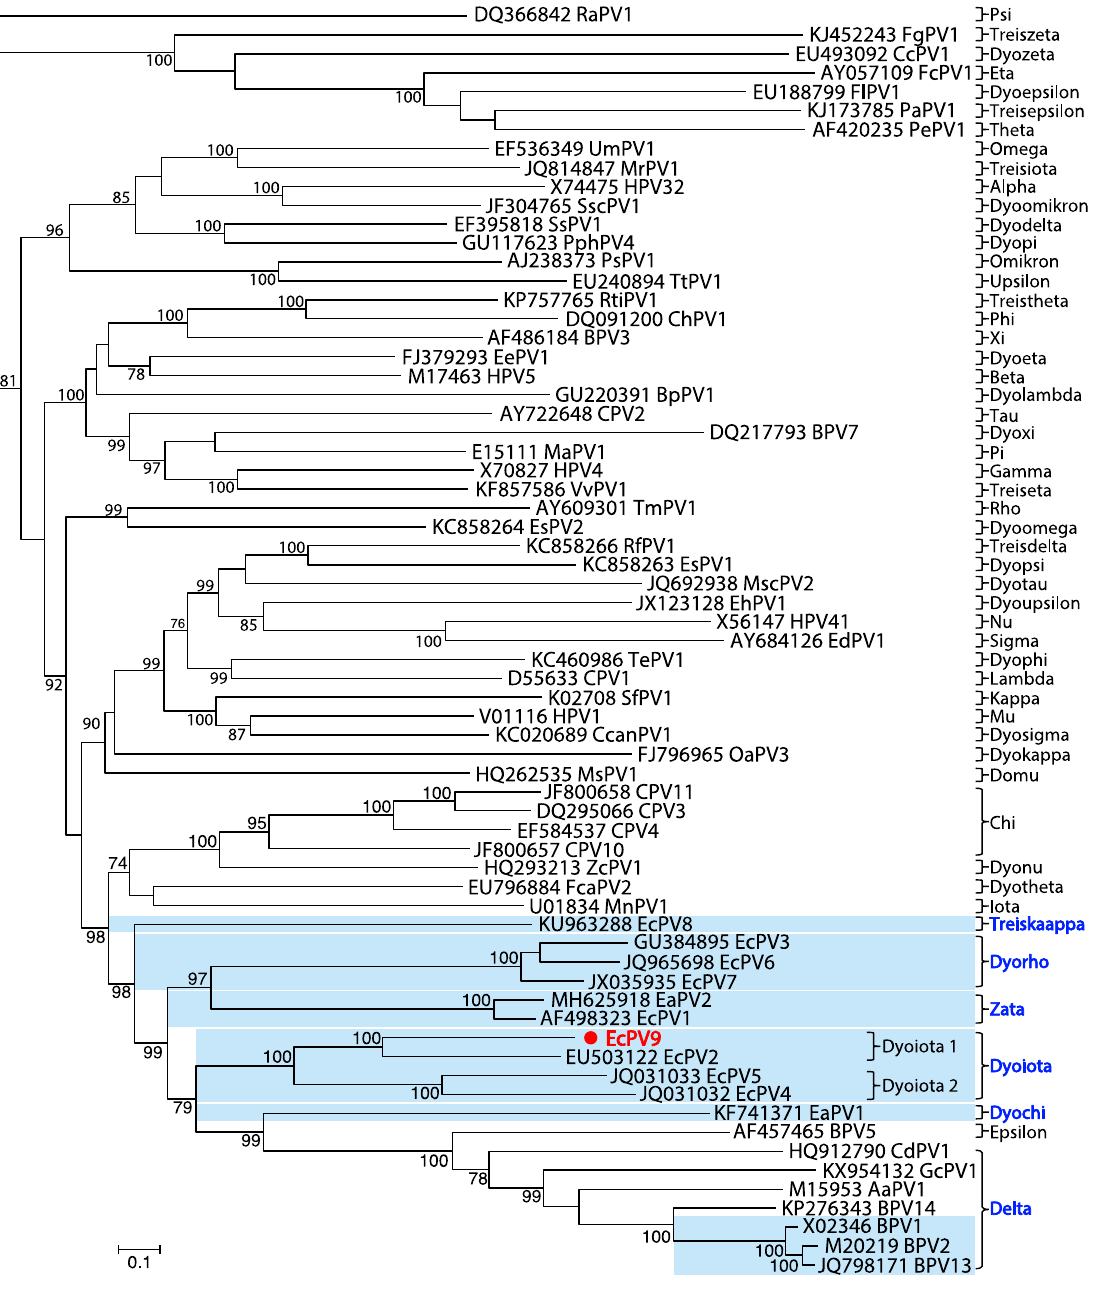
Figure 3. Phylogenetic relationships of EcPV9 to other papillomaviruses based on an analysis of concatenated E1, E2, L2, and L1 amino acids sequences. EcPV9 is shown in red. The names of reference sequences, that contain both the GenBank accession number and the virus species name, are shown in black. Those papillomaviruses associated with horses are shown in a light blue background. The names of previously defined genera are shown to the right of the phylogenies. The tree is mid-point rooted for clarity and nodes supported by > 70% of bootstrap replicates are indicated.